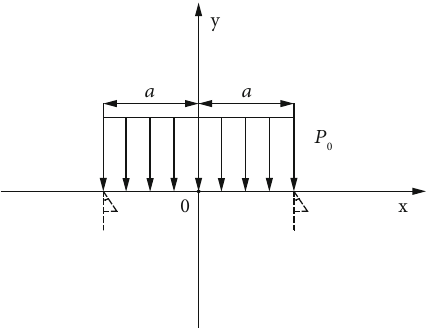
Figure 6: Basic mechanical constitutive model of wall